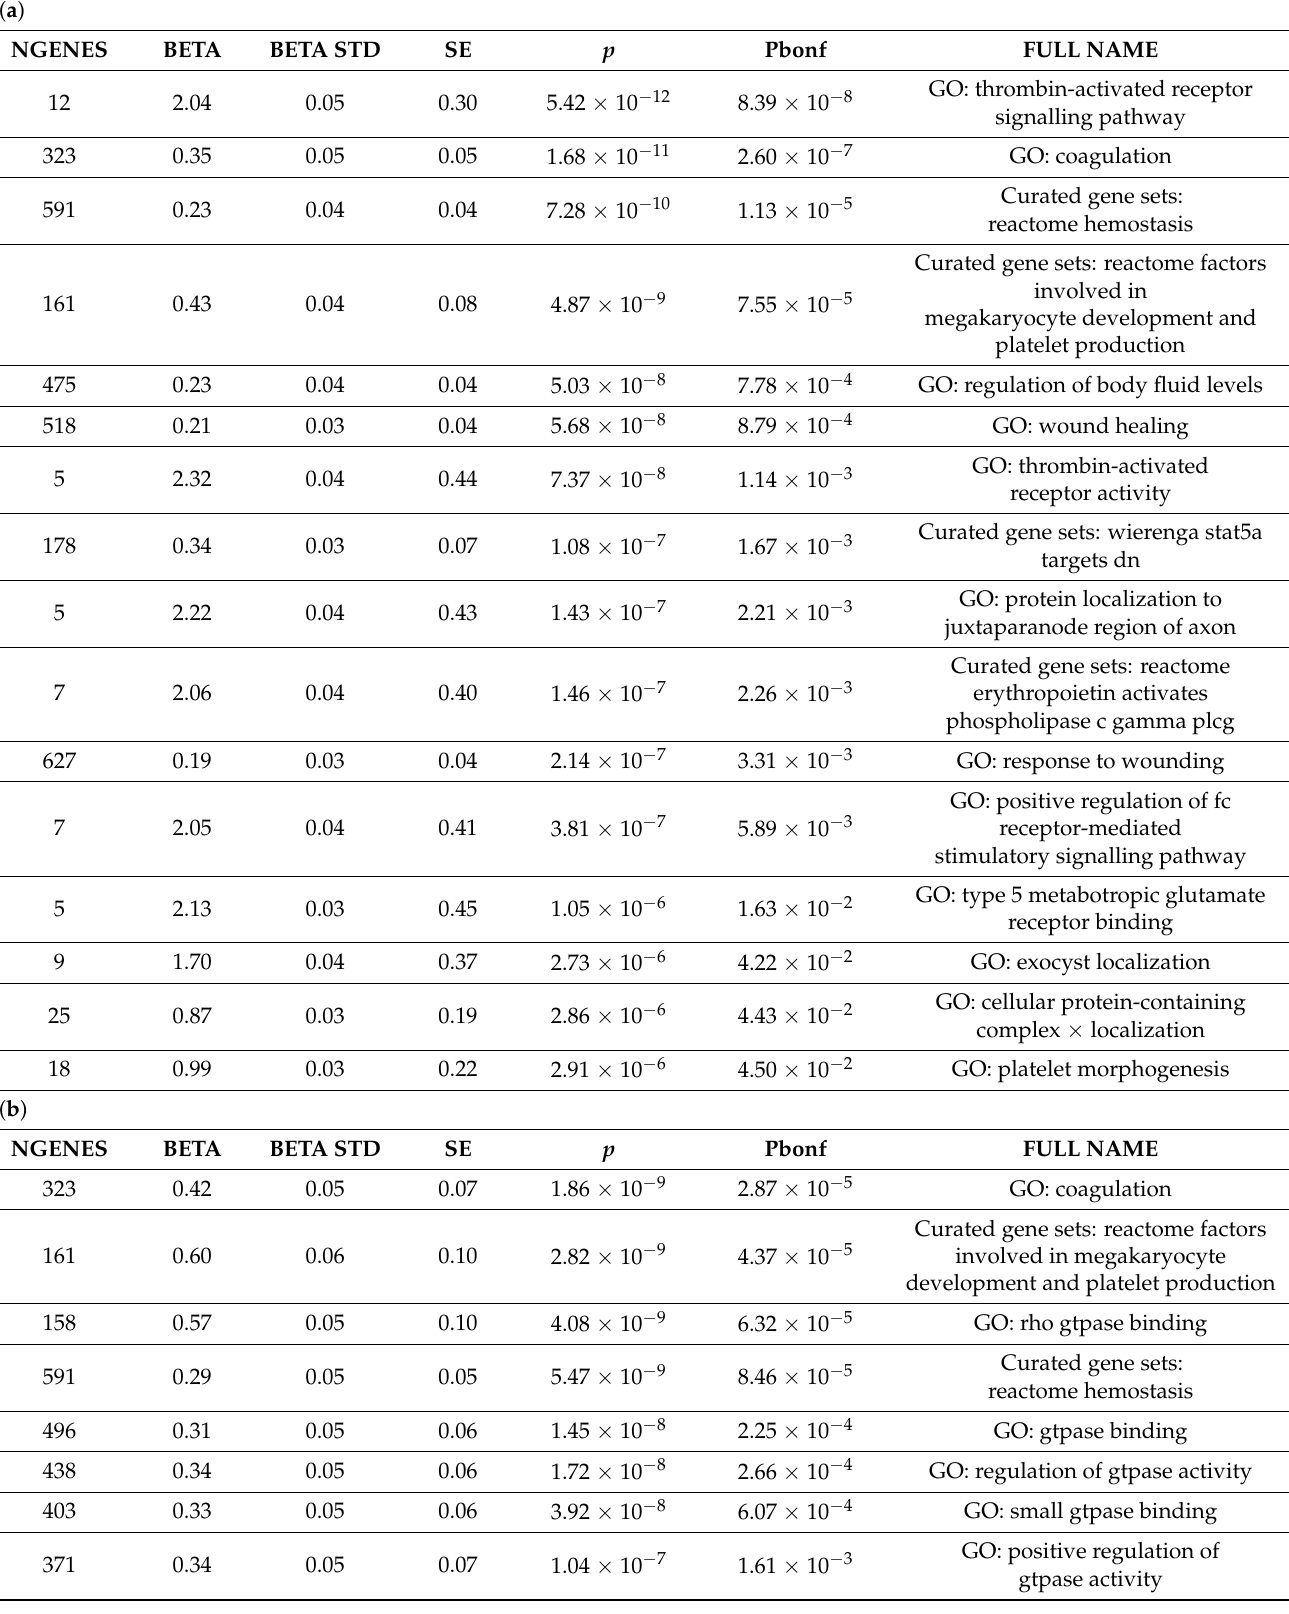
Table 3. Gene-Set enrichments of multitrait single-variant associations with ( a ) PD-AAO and ( b ) MPV. ( a